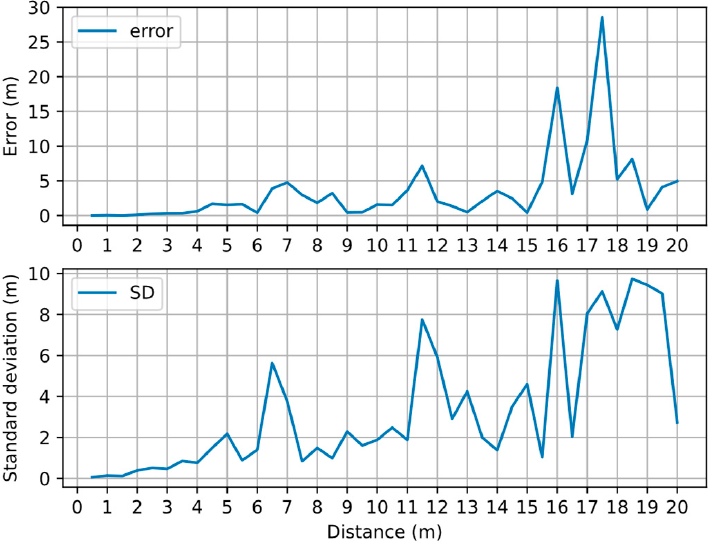
Figure 7. Error and standard deviation (SD) of BLE ranging at different distances.